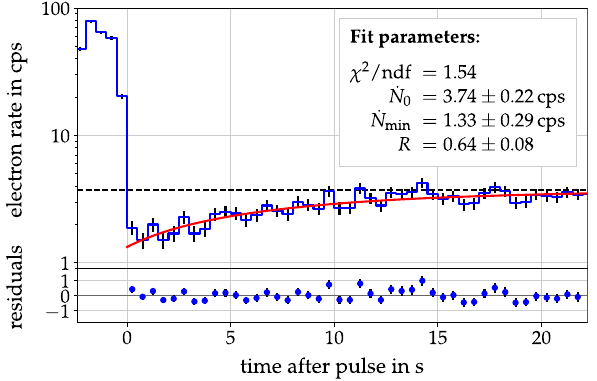
Fig. 6 Removal of stored electrons originating from a 220 Rn source by the magneticpulse. The pulse wasappliedevery25 s by invertingLFCS coils L1–L13 for 1 s at a nominal magnetic field B min = 0 . 38 mT. The plot shows the averaged electron rate from n = 73 pulse cycles, which werealignedusingthetiminginformationfromthereferencesignal.The electron rate between the pulse cycles is fit by an exponential model to determine the removal efficiency via Eq. (10). The rate increases gradually during the relaxation period as the number of stored electrons